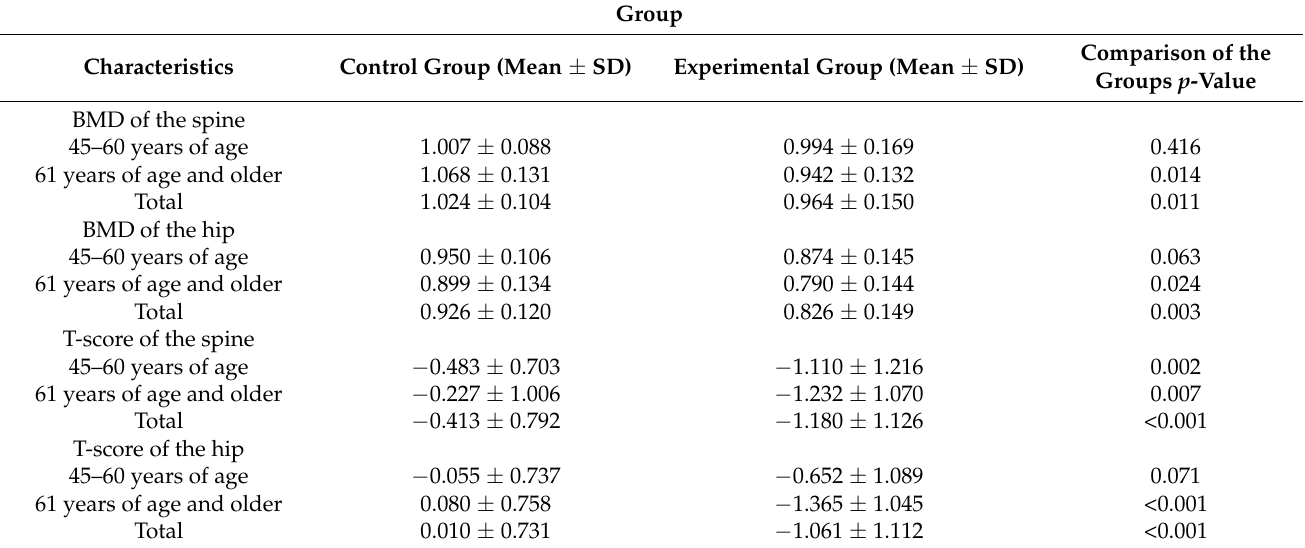
Table 2. BMD (g/cm 2 ) and T-score values of the spine and hip in experimental OA and controls.